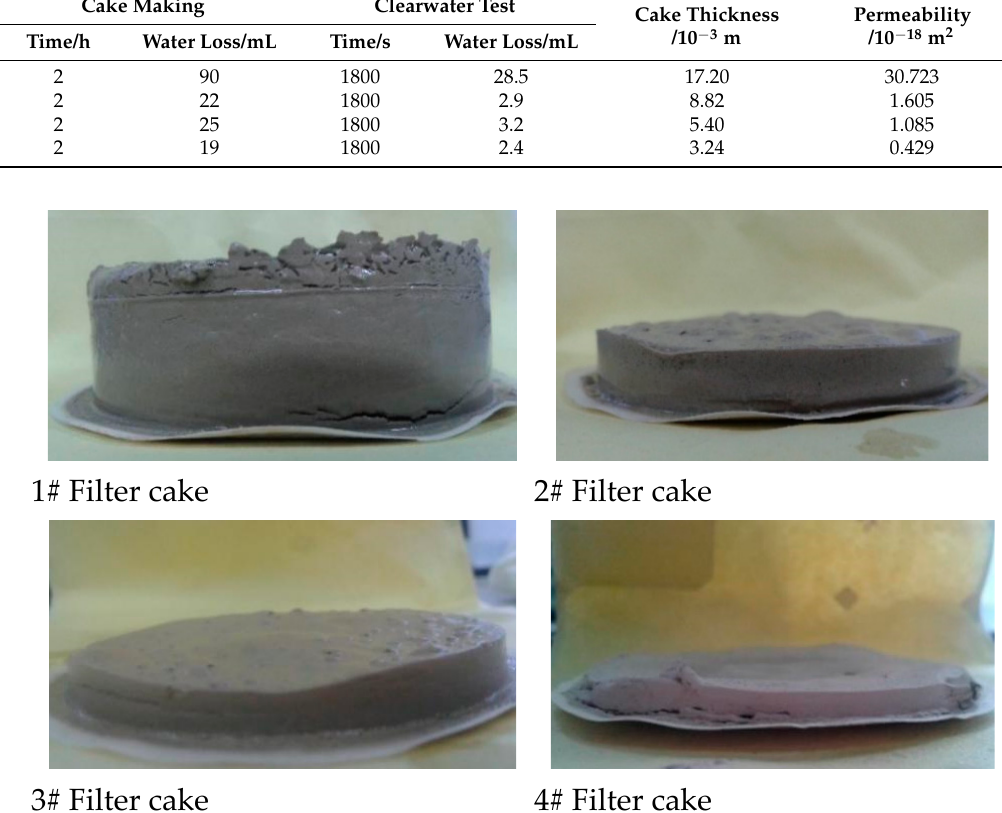
Table 2. Performance of fi lter cake under di ff erent compound barite conditions.